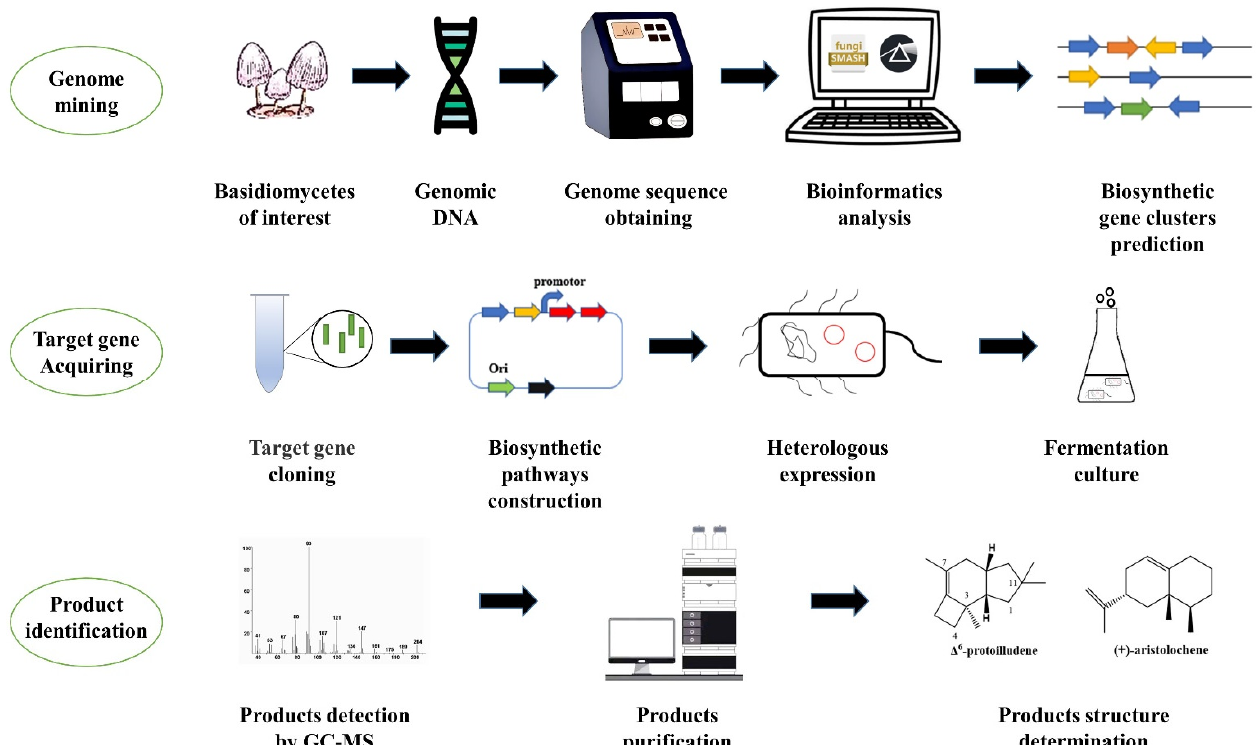
Figure 4. Technical research route of STS in basidiomycetes. The STS genome mining of basidiomycetes can be divided into three steps. The first step of genome mining is mainly based on the whole gene sequence, using bioinformatics tools to mine and predict the biosynthetic gene cluster. The second step is to obtain the target gene from the biosynthetic gene cluster of STS, and then heterologously express the target gene to obtain the product. The final step is to purify and identify the product to determine whether the gene is an STS.